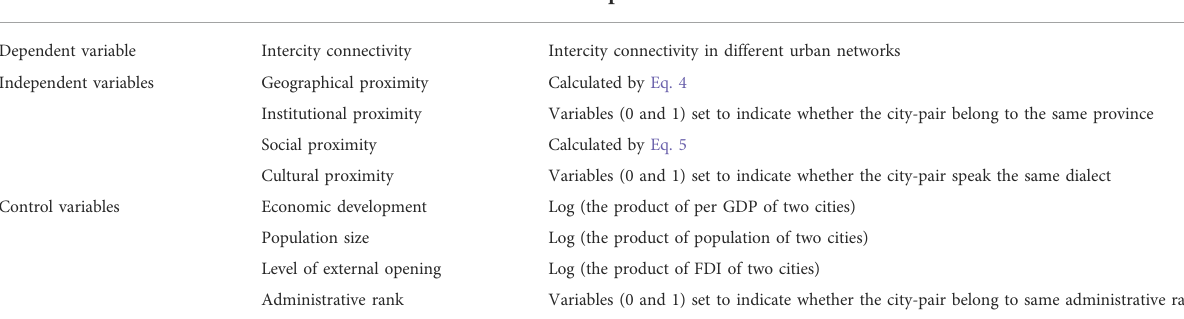
TABLE 1 Main variables and measurement